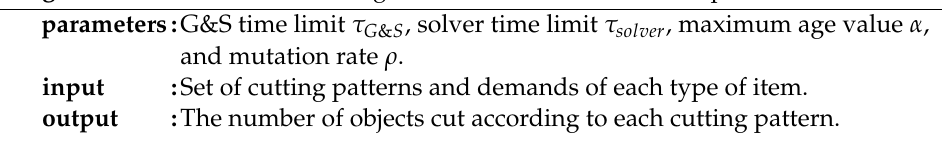
Algorithm 1: Pseudocode of the generate-and-solve method